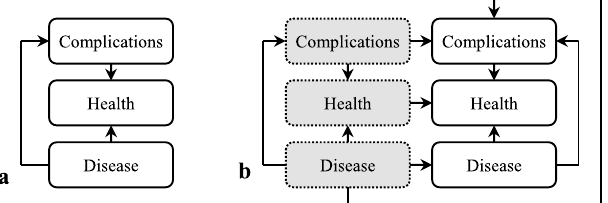
Figure 8. Simple Bayesian network modeling the health condition. ( a ) the static network defining the initial state at t = 0 and ( b ) the dynamic network defining the state of nodes in two consecutive time slices, i.e. t-1 (gray background and dotted border) and t (white background and solid border) and transition between them (solid lines with